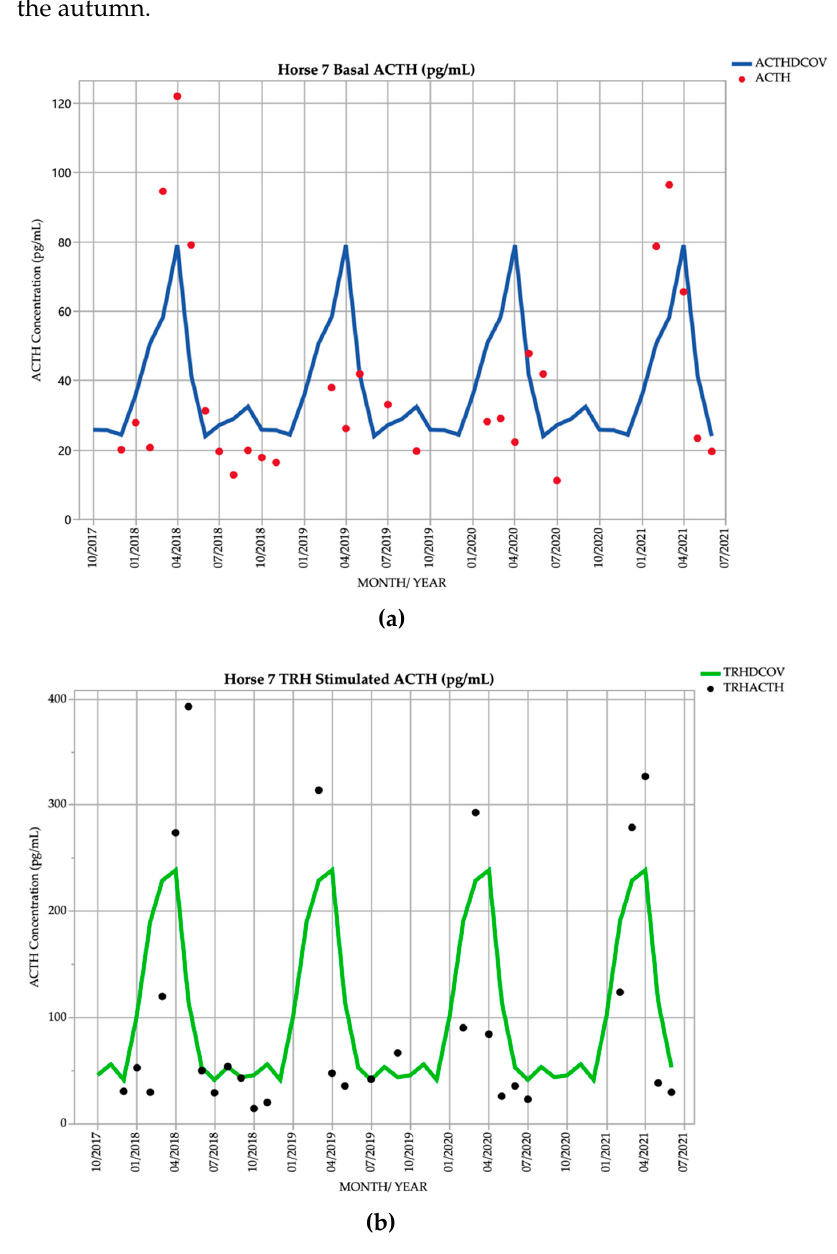
Figure 7. Monthly ACTH concentration (pg/mL) in Horse 7 (18 ‐ year ‐ old Standardbred gelding), compared to locally derived, seasonally adjusted DCOV [2]. ( a ) Basal ACTH concentrations (red points) and basal ACTH DCOV (blue line) (b) TRH ‐ stimulated ACTH concentrations (black points) and TRH ‐ stimulated ACTH DCOV (green line).